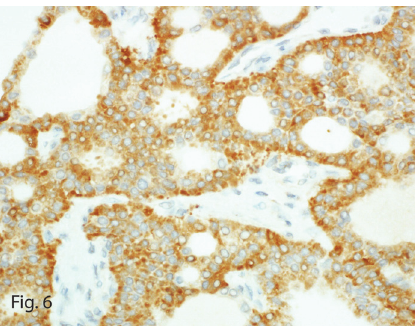
Figure 6: Synaptophysin immunoexpression in the tumor (original magnification × 40).